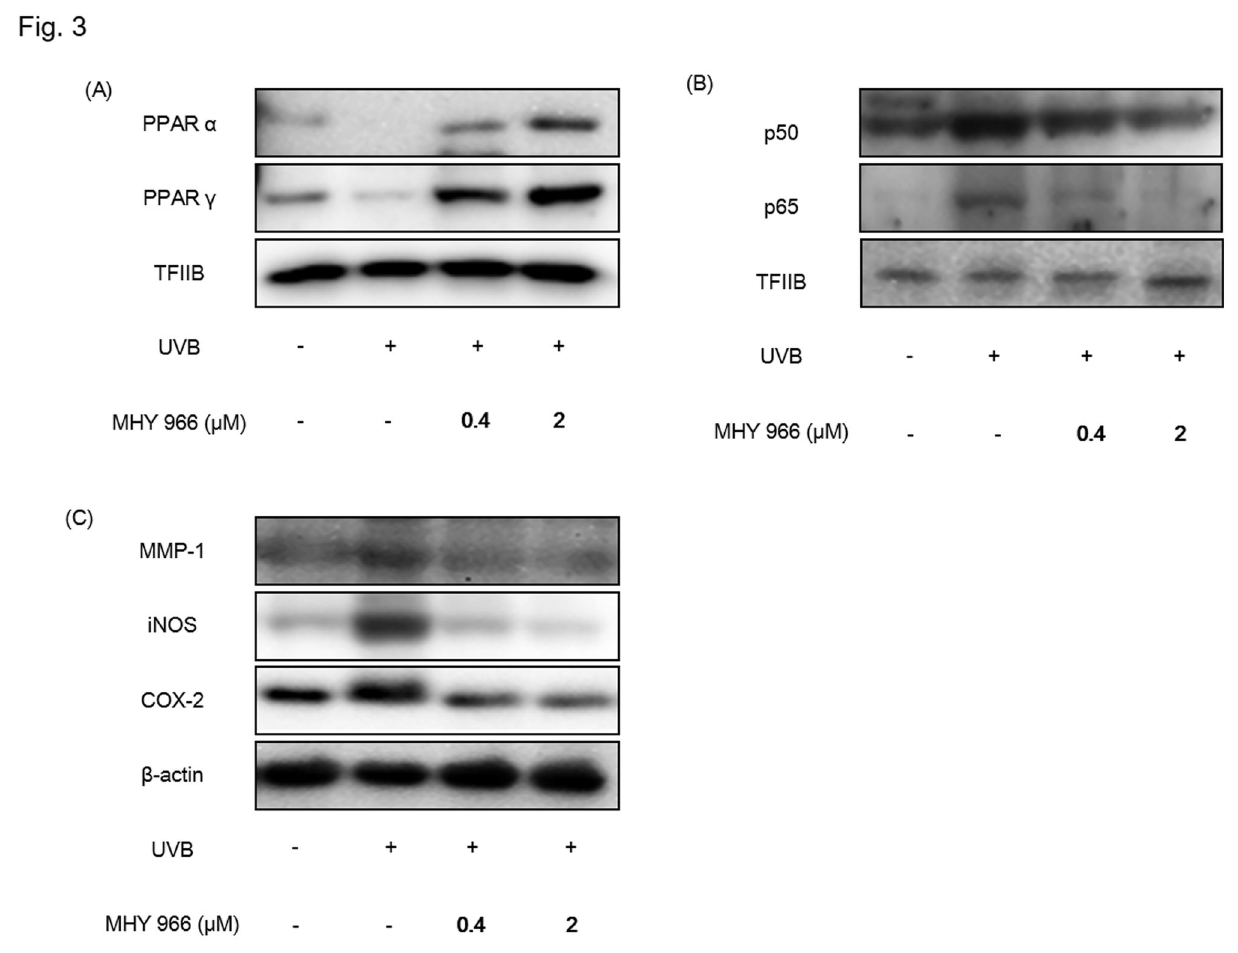
Figure 3. MHY 966 both activated PPAR α and γ, and inhibited inflammatory responses in UVB-induced HRM2 mouse skins. Western blot analysis was performed to detect the levels of PPAR α PPAR γ (A), NF-κB (B), MMP-1, COX-2 and iNOS (C) in skin hommogenate. TF Ⅱ B and β-actin blots were shown to clarify the same amount of protein loaded in nuclear and cytosolic fraction, respectively. 0.4 or 2 μM of MHY 966 was topically applied on dorsal skin daily at for 17 days and then exposed to UVB using a BEX-800 UVB lamp (UltraLun, Claremont, Ca, USA) at 150 mJ/cm 2